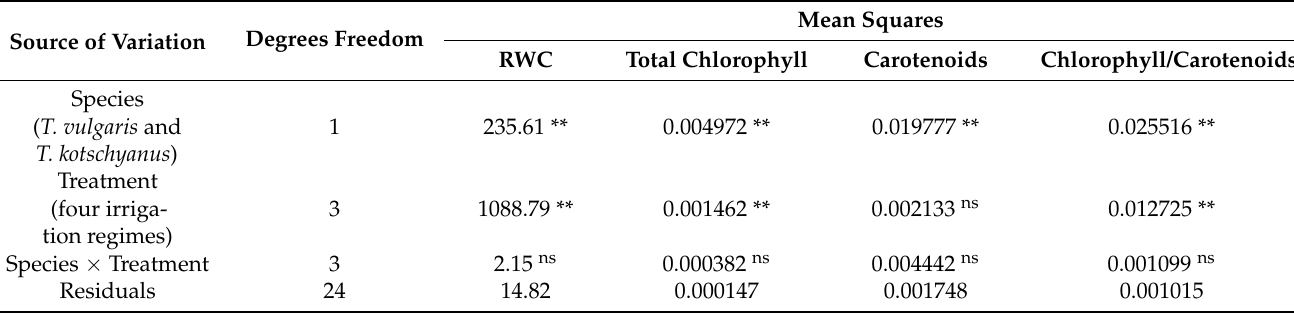
Table 3. ANOVA of physiological